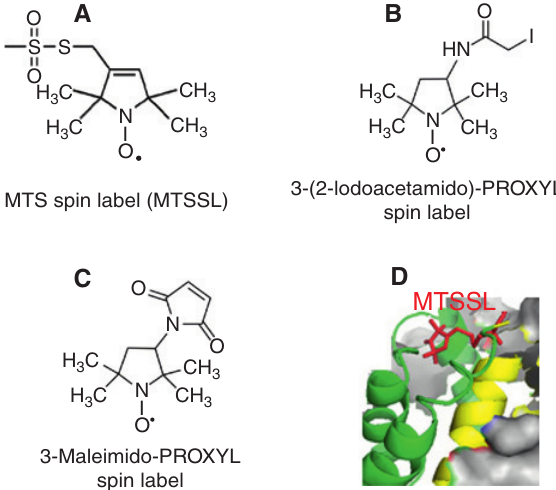
Figure 1: Nitroxide spin-labels commonly used in EPR studies of proteins. (A) MTS spin-label (MTSSL,S-(1-oxyl-2,2,5,5-tetramethyl- 2,5-dihydro-1H-pyrrol-3-yl)methyl methanesulfonothioate), which is currently the most widely used spin-label; (B) iodoacetamido- PROXYL spin-label, (C) maleimido-PROXYL spin-label; (D) MTSSL attached to a cysteine residue in a protein polypeptide chain is shown as sticks in red. The side chain of cysteine labeled with MTSSL was produced using MMM software (Polyhach and